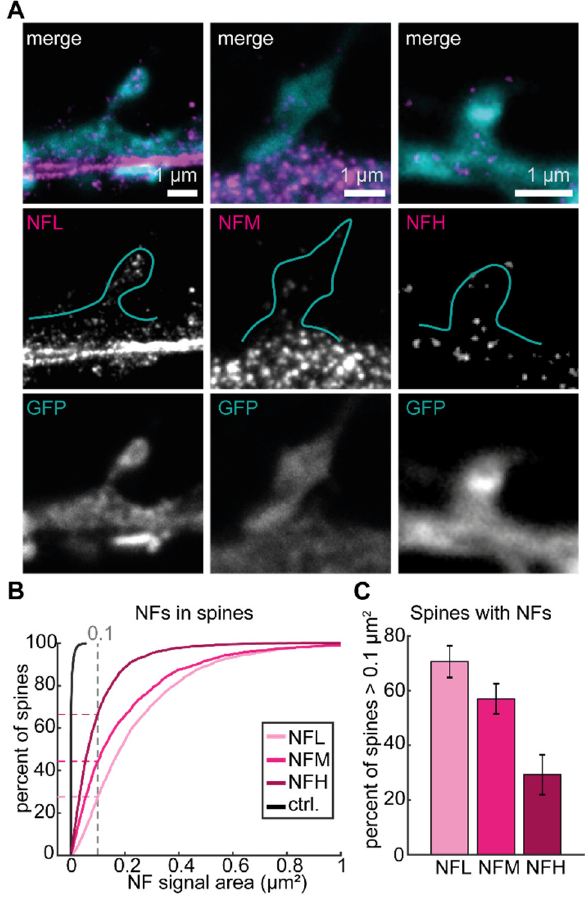
Figure 2. NF isoforms are found at the postsynapse. ( A ) Representative STED images of dendritic spines with NFs (magenta) and volume labeling (confocal, cyan) with NFL (left), NFM (middle), or NFH (right). Spine shape as seen in volume labeling is represented in cyan outline. Scale bars are 1 µm. ( B ) Cumulative distribution of spines containing NFs compared to control without primary antibody labeling. Dashed lines indicate individual values at a 0.1 µm² threshold. ( C ) Percentage of spines containing more than 0.1 µm² of NF signal. Data was calculated from a total of 7115 spines (NFL = 2242, NFM = 1775, NFH = 2342, ctrl = 756) manually segmented from 34–40 images per isoform from 8 independent neuronal cultures (14–36 DIV), 15 images from 3 independent neuronal cultures for ctrl). Error bars show the standard error of the mean (SEM).